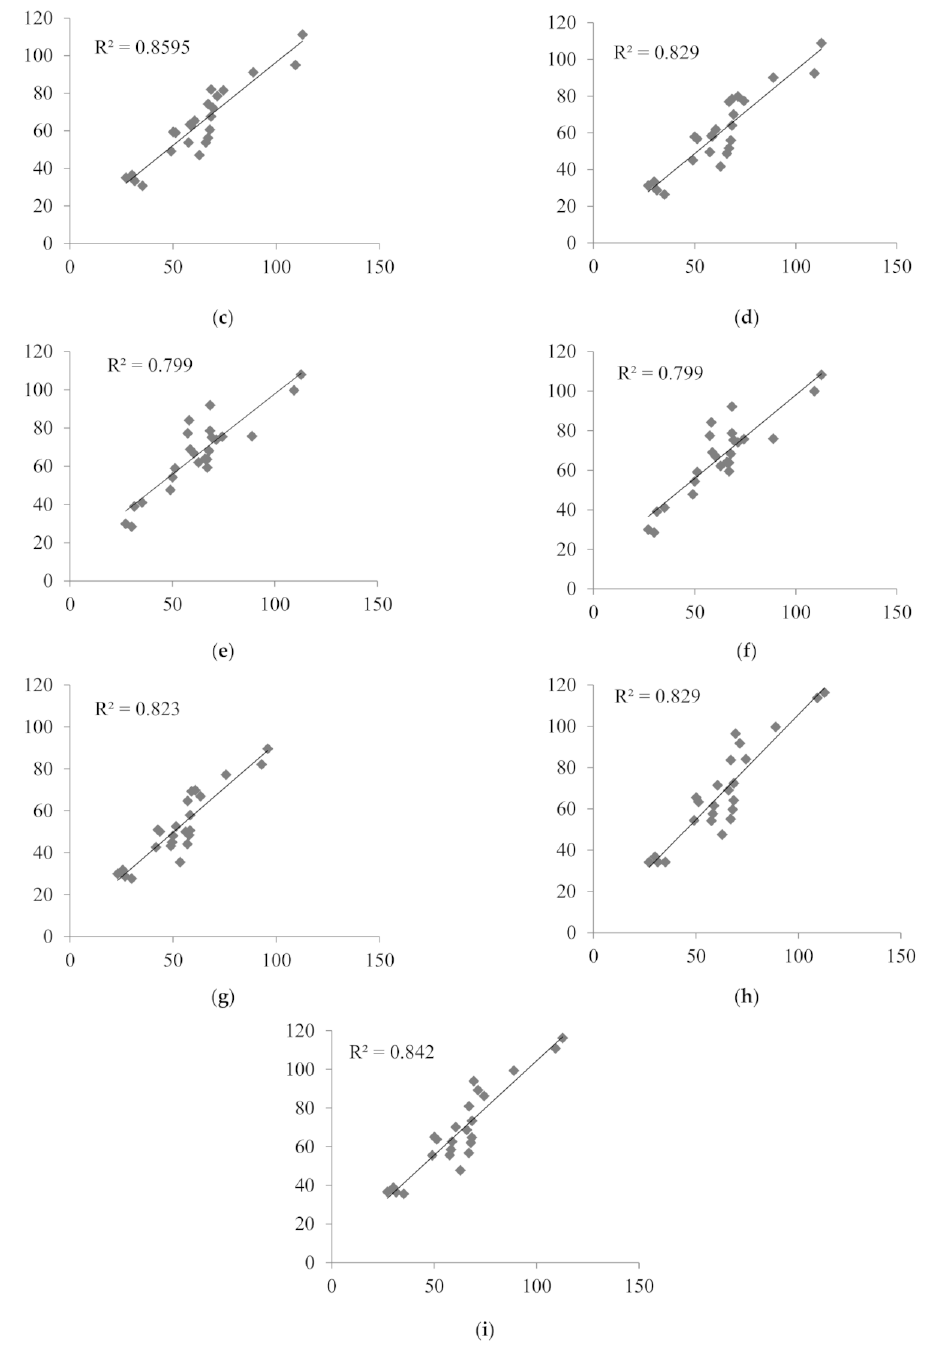
Figure 2. Correlations between the MPA AUC total and the MPA AUC pred calculated for children with nephrotic syndrome using MLR LSS equations found in the literature that fulfilled the criteria for %MPE and %MAE ± 15%; ( a ) AUC pred = 7.4 + 2.3 × C 0 + 1.2 × C 1 + 2.3 × C 3 + 4.4 × C 6 [30]; ( b ) AUC pred = 9.328 + 1.311 × C 1 + 1.455 × C 2 + 2.901 × C 4 [43]; ( c ) AUC pred = 10.6 + 1.1 × C 1 + 1.1 × C 2 + 2.0 × C 4 + 3.9 × C 6 [30]; ( d ) AUC pred = 5.92 + 1.10 × C 1 + 1.01 × C 2 + 1.77 × C 4 + 4.80 × C 6 [28]; ( e ) AUC pred = 8.22 + 3.16 × C 0 + 0.99 × C 1 + 1.33 × C 2 + 4.18 × C 4 [32]; ( f ) AUC pred = 8.217 + 3.163 × C 0 + 0.994 × C 1 + 1.334 × C 2 + 4.183 × C 4 [8]; ( g ) AUC pred = 10.229 + 0.925 × C 1 + 1.750 × C 2 + 4.586 × C 6 [29]; ( h ) AUC pred = 7.73 + 0.94 × C 1 + 2.55 × C 2 + 5.48 × C 6 [32]; ( i ) AUC pred = 10.75 + 0.98 × C 1 + 2.38 × C 2 + 4.86 × C 6